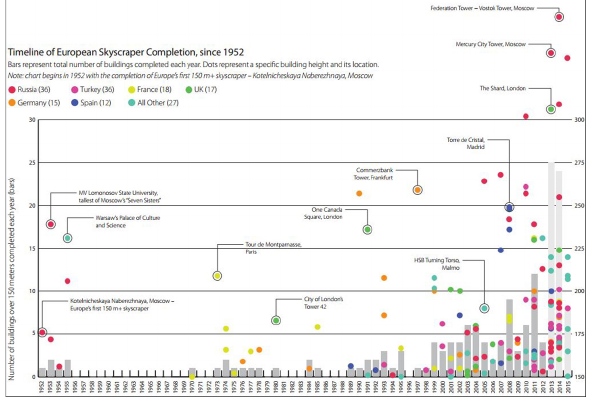
Figure 2. Development of European tall buildings in time-line since 1952, by: CTBUH Journal, 2013 Issue II